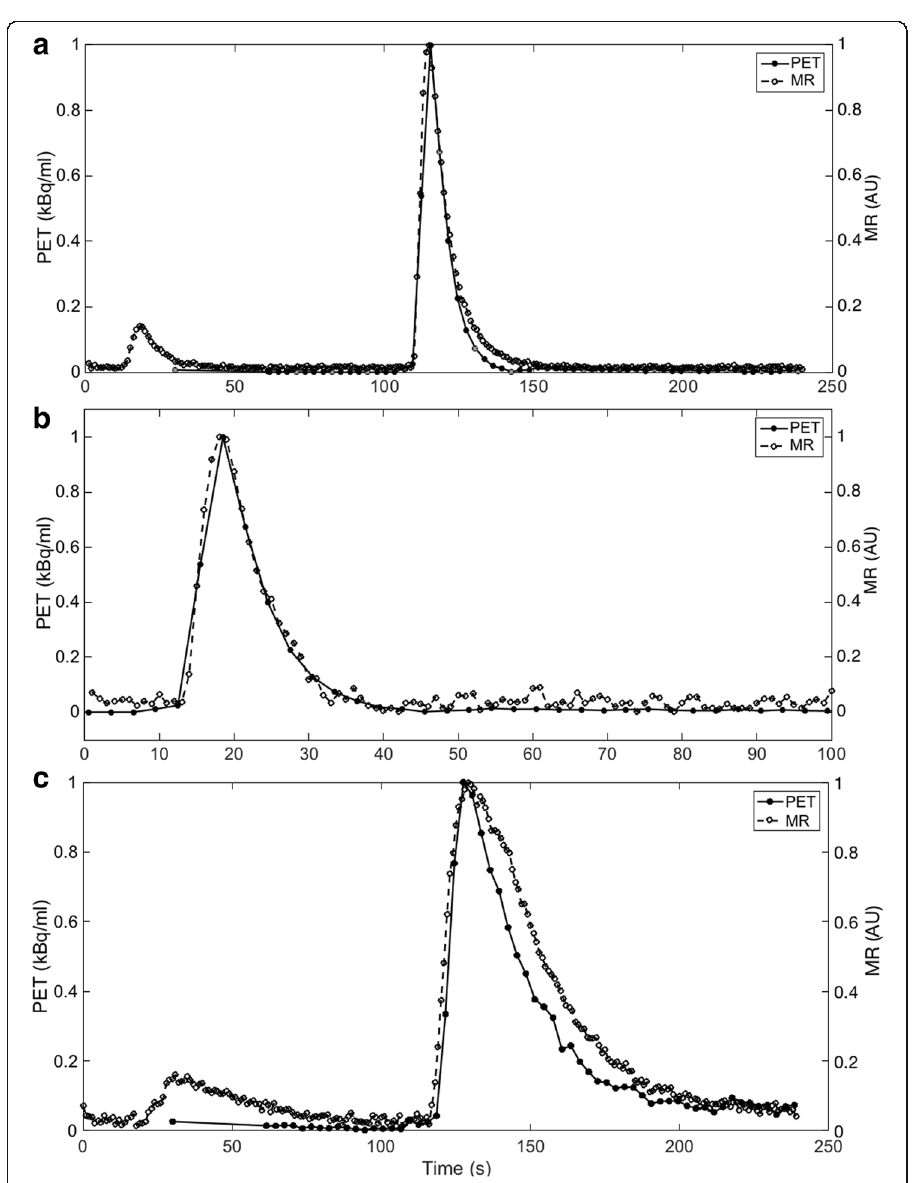
Fig. 5 Comparison of normalized (respective maximum signal intensity) AIFs derived from both PET and MR signal traces at a myocardial perfusion rate of 4 ml/g/min and cardiac output of 3 l/min. Image ( a ) represents the input functions from the main MR bolus and PET bolus, showing a longer washout of GBCA than radiotracer in the main bolus. Image ( b ) details the MR prebolus with the same PET bolus as ( a ) but time-shifted to provide comparison. Image ( c ) details the simultaneous curves from the myocardial compartment showing a clear difference in transit time, potentially due to higher mass and viscosity of the